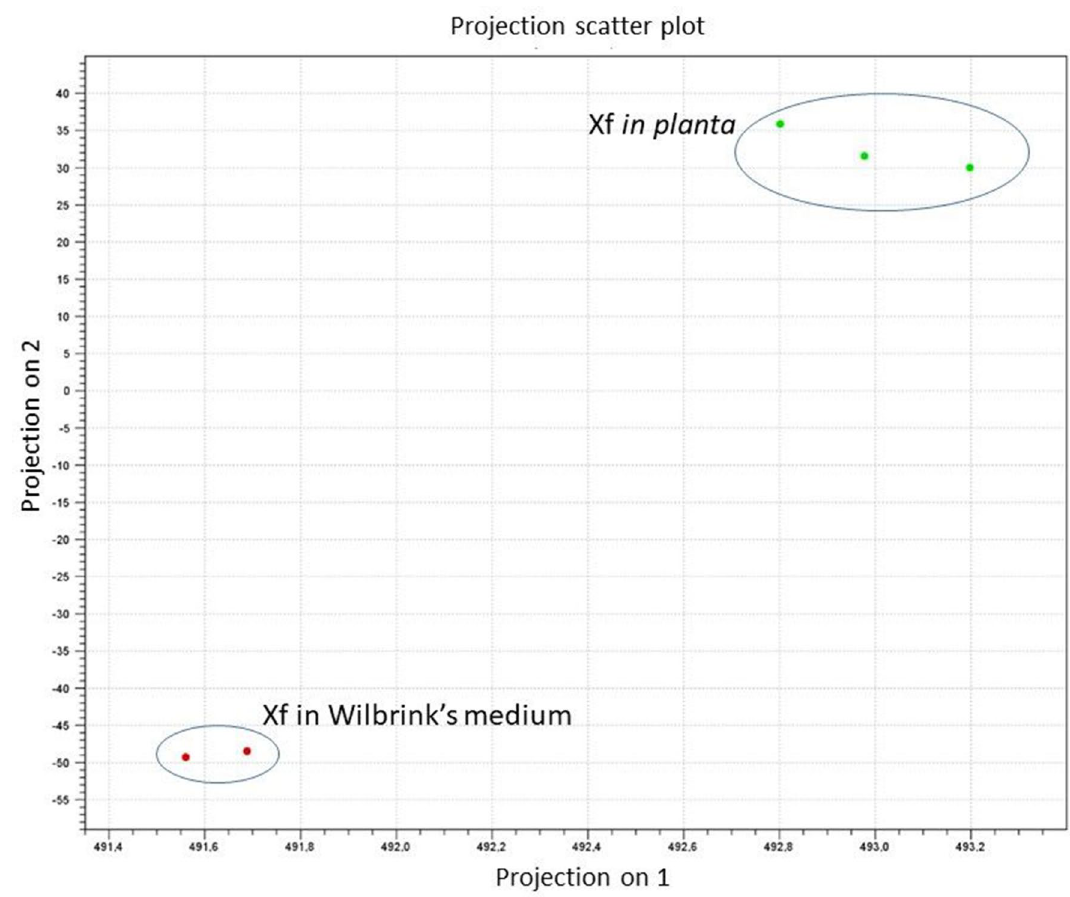
Figure 1. Principal component analysis (PCA) of the log 2 -transformed normalized expression values indicating the variation between Xanthomonas fragariae ( Xf ) grown overnight in liquid Wilbrink’s medium and in planta and between replicate samples at 15 days after